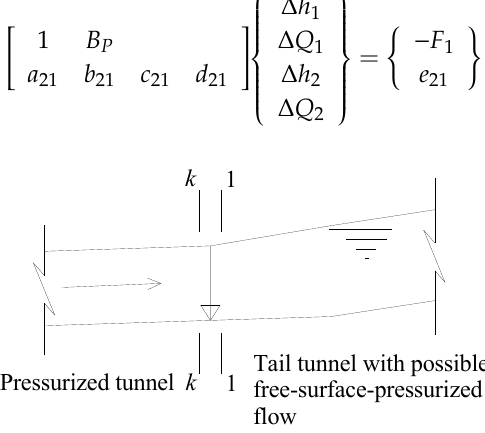
Figure 2. Inlet section of a tail tunnel with free-surface-pressurized flow.